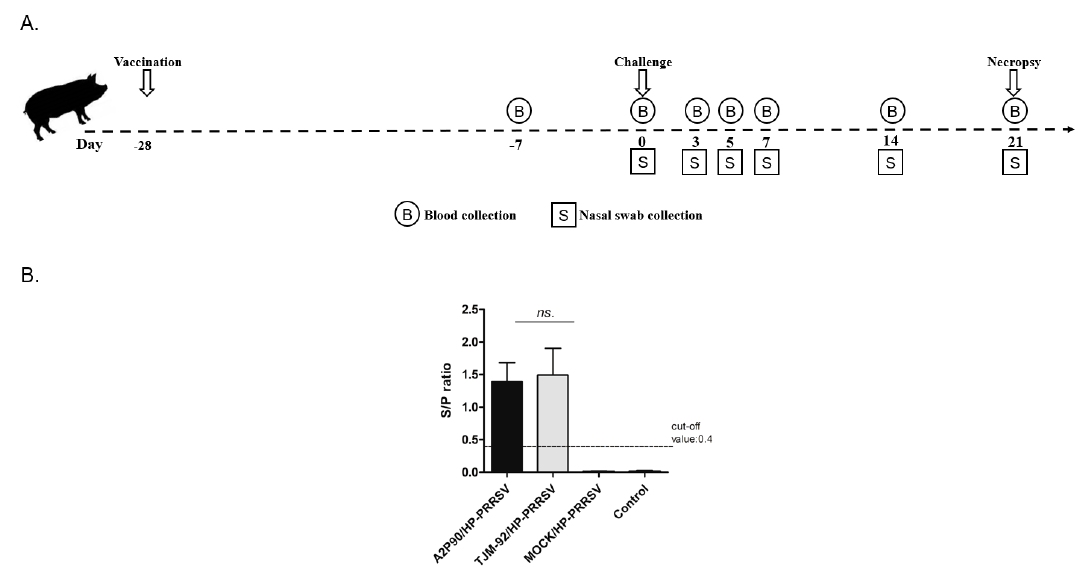
Figure 1. Schematic illustration of experimental protocol and ELISA examination of seroconversion prior to the porcine reproductive and respiratory syndrome virus (PRRSV) challenge. ( A ). After piglets were housed, A2MC2-P90 and TJM-F92 were used to vaccinate animals via the intramuscular route using 1 mL of virus stock (1.0 × 10 6 TCID 50 /mL). At 21 days post vaccination, serum samples were collected then at day 0 piglets were challenged with HP-PRRSV-XJ1. Blood and nasal swab samples were collected at indicated time points and all surviving animals were necropsied at 21 dpc. ( B ). After immunization of piglets with A2MC2-P90 and TJM-F92, serum samples were collected 21 days later and examined to detect seroconversion using an IDEXX HerdChek PRRS X3 ELISA kit. All experiments were repeated at least three times for each serum sample. Data are expressed as the mean ± SD and were subjected to Student’s t -test. No significant differences (NS) were observed between groups immunized with A2MC2-P90 or TJM-F92.